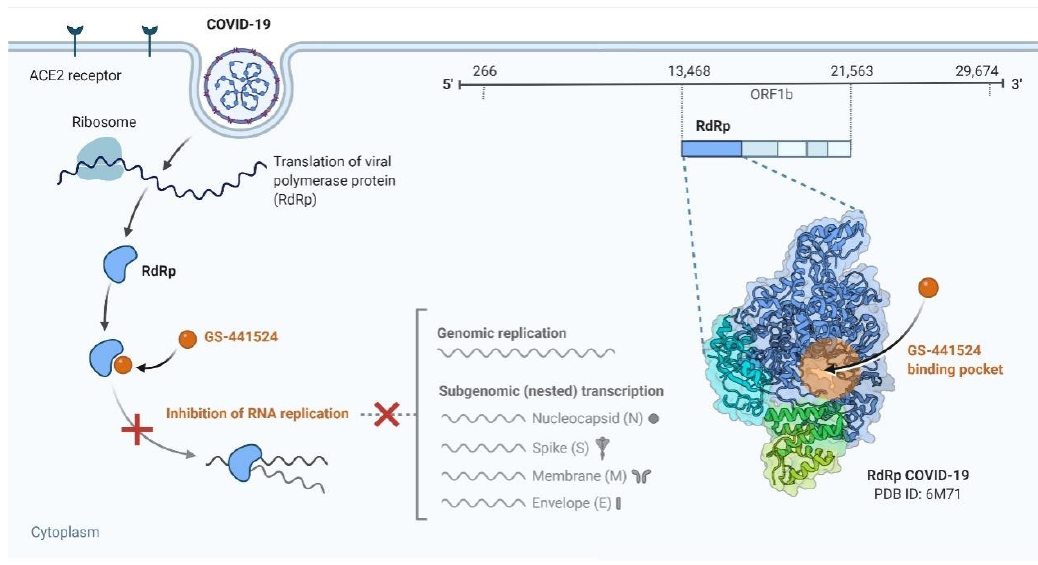
Figure 4. Remdesivir is a potential repurposed drug candidate for COVID-19.